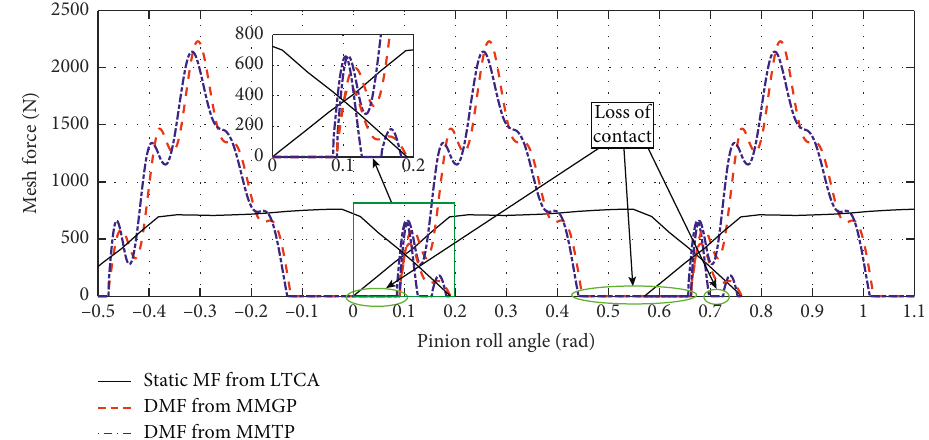
Figure 19: Time histories of DMF per tooth pair at the mesh frequency of 400Hz and 50Nm torque